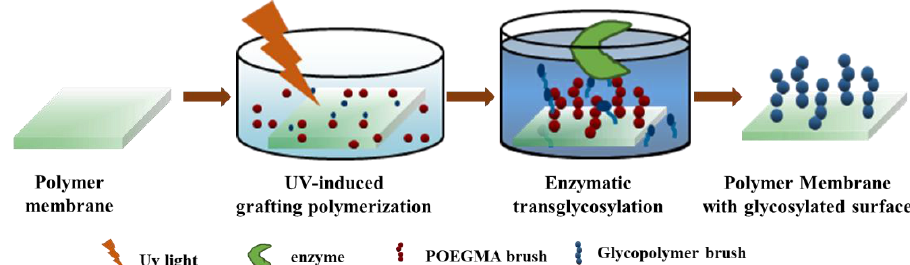
Figure 1. Scheme illustrating the overall chemo-enzymatic strategy for fabricating polymer membrane with glycosylated surface. First, a poly (oligo(ethylene glycol) methyl methacrylate) (POEGMA) brush was introduced onto the surface of the microporous polypropylene membrane (MPPM) via UV-induced grafting polymerization. Then, galactose moieties were conjugated onto the membrane surface via galactosidase-catalyzed transglycosylation.